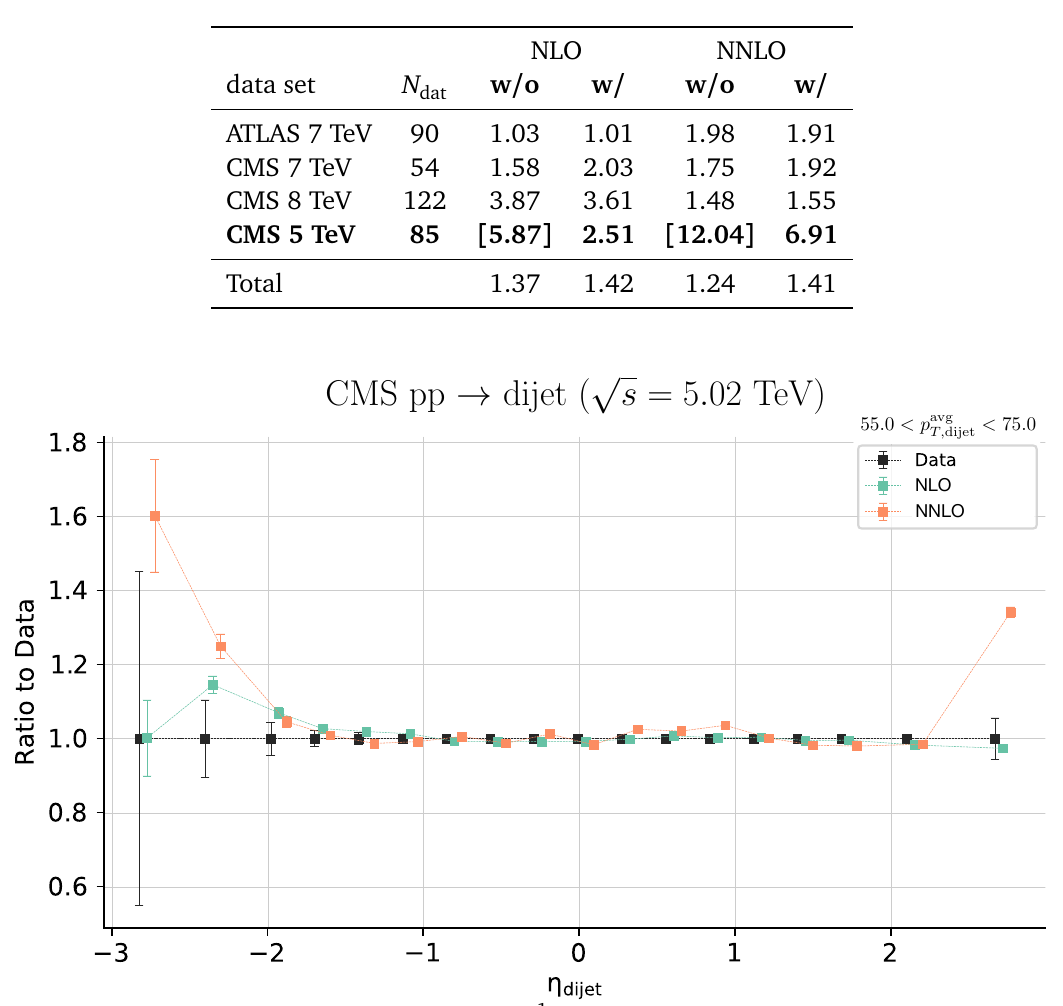
Table 1: The χ 2 per data point for the two new proton baselines: nNNPDF2.0 ∗ ( 1 p ) at NLO and NNLO. Results are shown for the dijet data sets together with the number of data points in each data set.